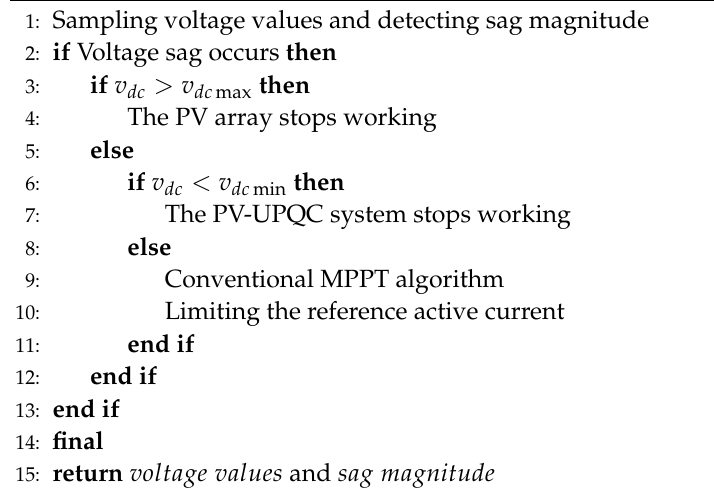
Algorithm 1 The proposed coordination control